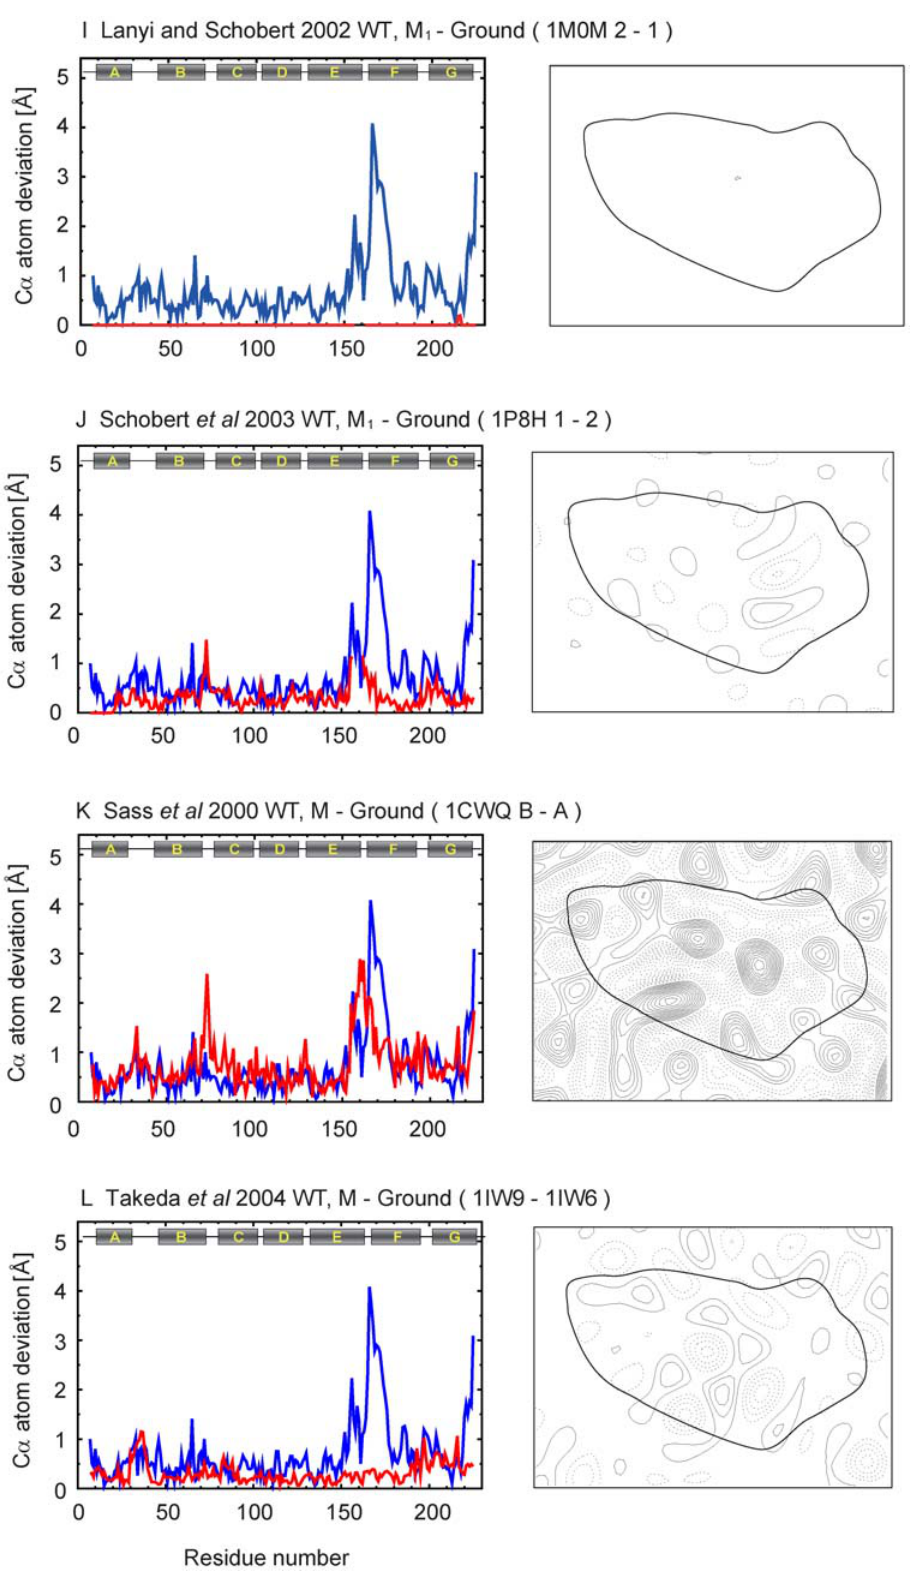
Figure 7. C a atom deviation plots and difference maps between intermediate and ground states calculated at 7 A˚ (continued).